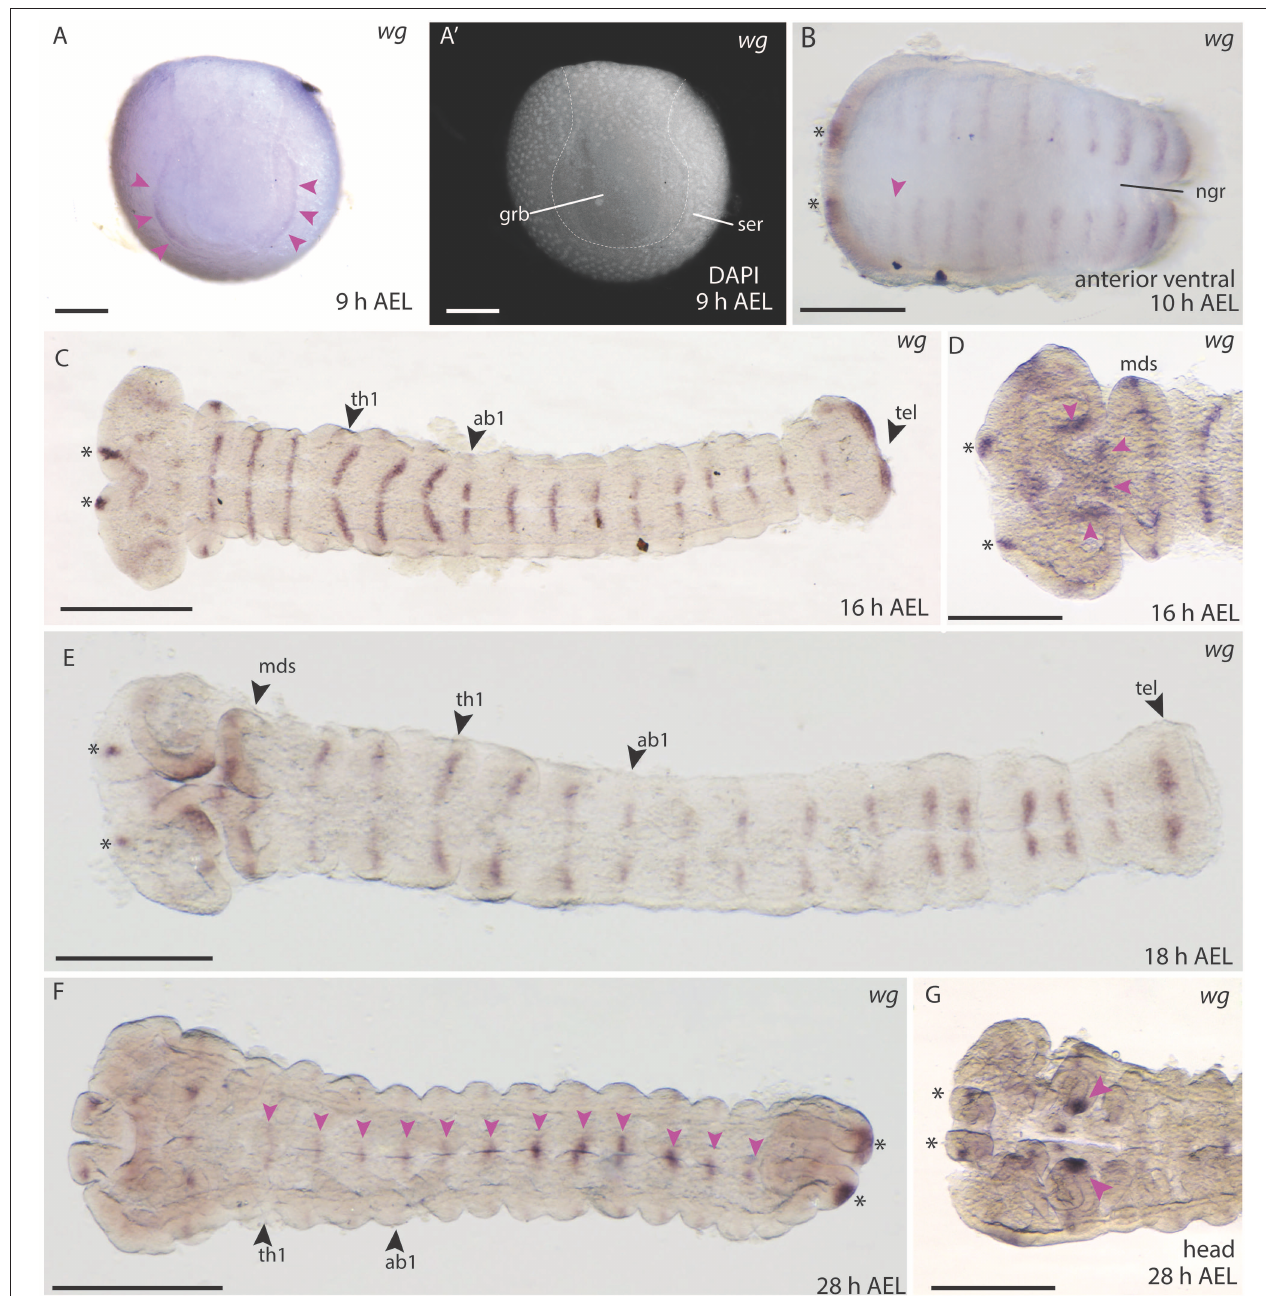
FIGURE 8 | Wnt1/wg expression during embryogenesis in B. anynana. (A,A ′ ) Early expression of wg at the anterior rim of the germ disc. (A ′ ) Indicating morphology with DAPI. (B) Expression in segmental stripes at 10h AEL. (C) Segmental expression of wg at 16h AEL. (D) Higher magnification of head staining at 16h AEL. (E) Expression at 18h AEL showing segmental stripes. (F) wg expression at 28h AEL along the A-P axis (pink arrowheads) and in the telson (asterisks). (G) Magnification of the head at 28h AEL indicating strong expression in mandibular segments (pink arrowheads). All pictures are orientated with anterior to the left if not otherwise stated. ab1-3, abdominal segments 1-3; AEL, after egg laying; grb, germ band; h, hour; hdl, head lobe; lbs, labial segments; mds, mandibular segments; mxs, maxillary segments; ngr, neurogenic furrow; ser, serosa; th1-3, thoracic segments 1-3. Scale bar: 400 µ